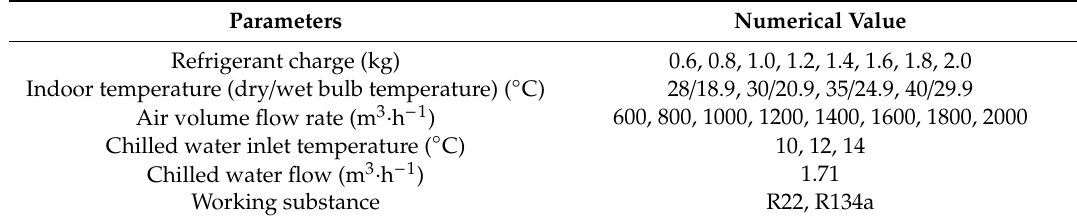
Table 1. Other experimental